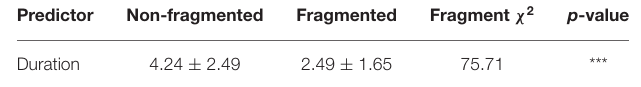
fixed factors in the statistical analysis (Utt1-Utt2-Utt3-Utt4).